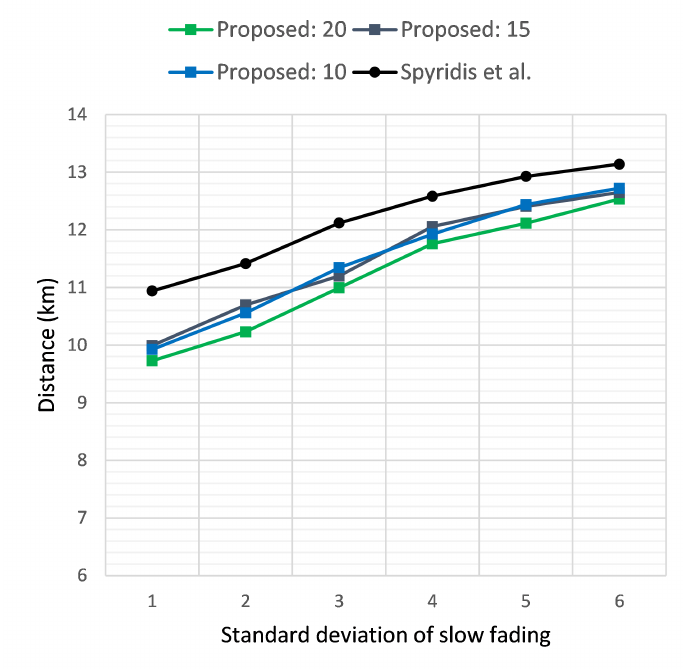
Figure 9. Average distance covered per UAV when the target sensor is placed at a distance of 3 km, versus the standard deviation σ of the additive noise. Comparison of the proposed method at clustering termination thresholds of 20, 15 and 10 dB and the previous approach.